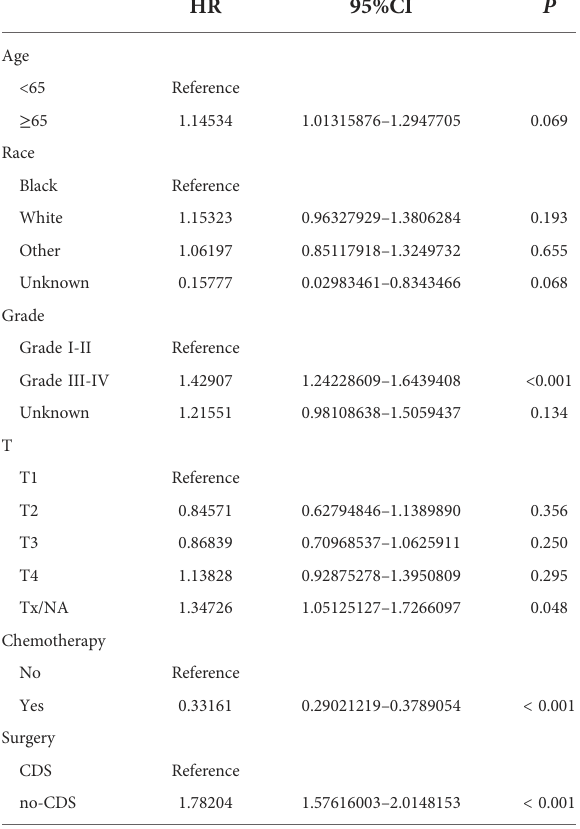
TABLE 3 Stepwise regression analysis method for automated model